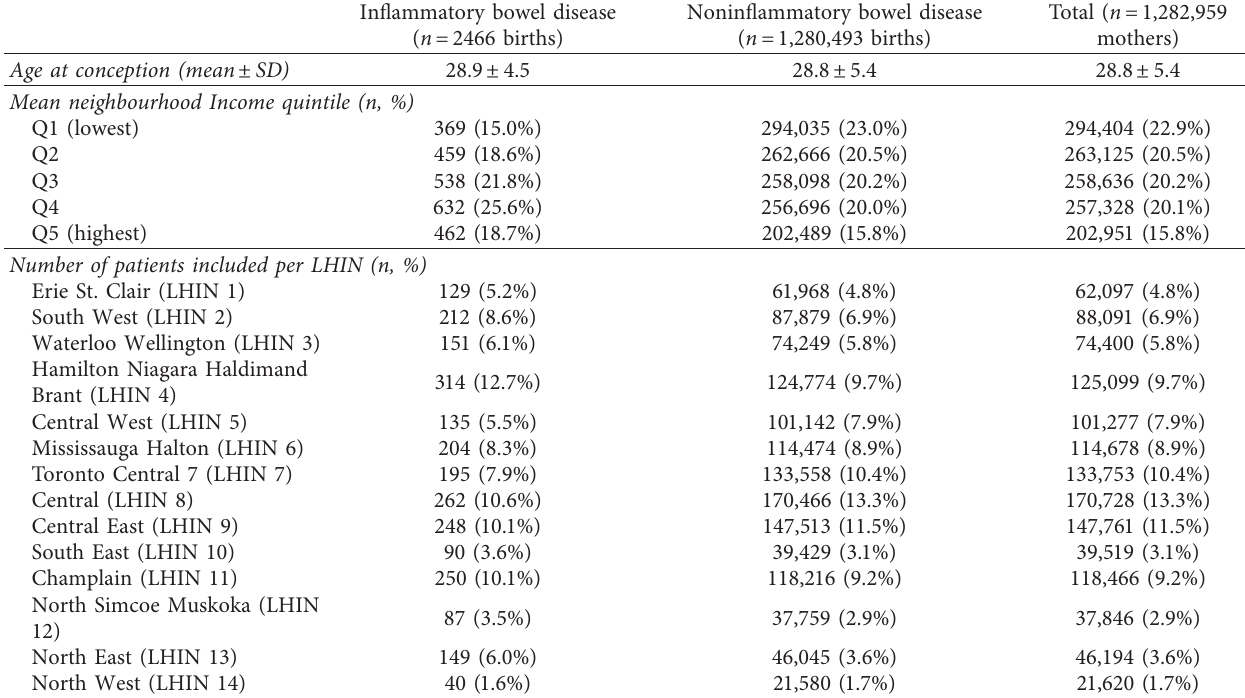
Table 1: Baseline characteristics of included patients and number of patients stratified by Local Health Integration Networks (LHINs).